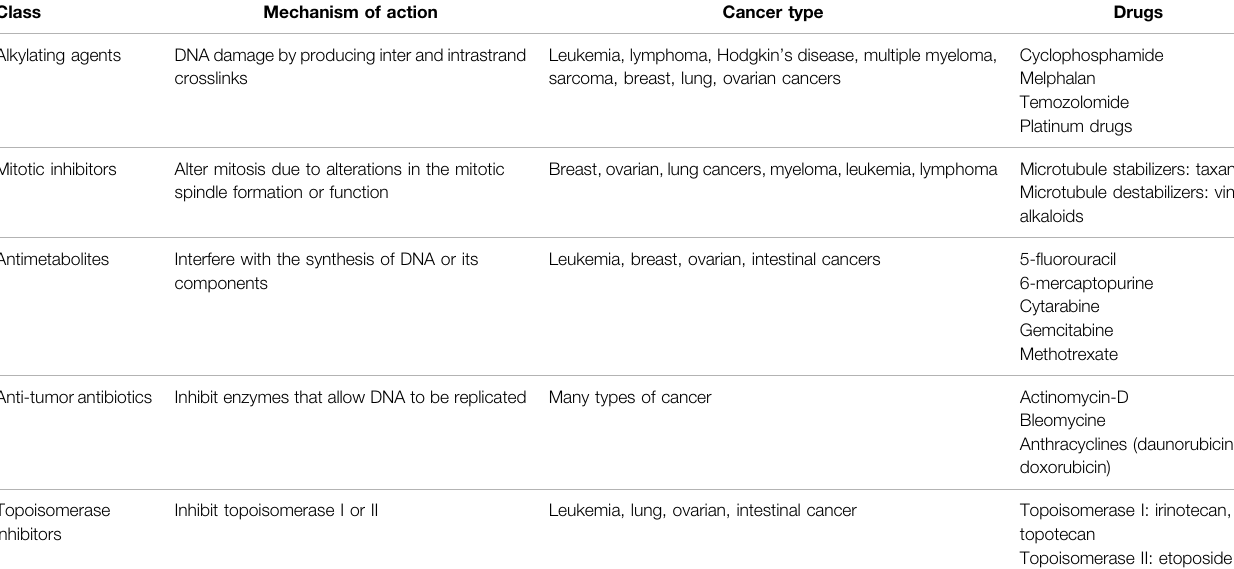
TABLE 1 | Main classes of cytotoxic antitumoral drugs according to their main mechanism of antiproliferative